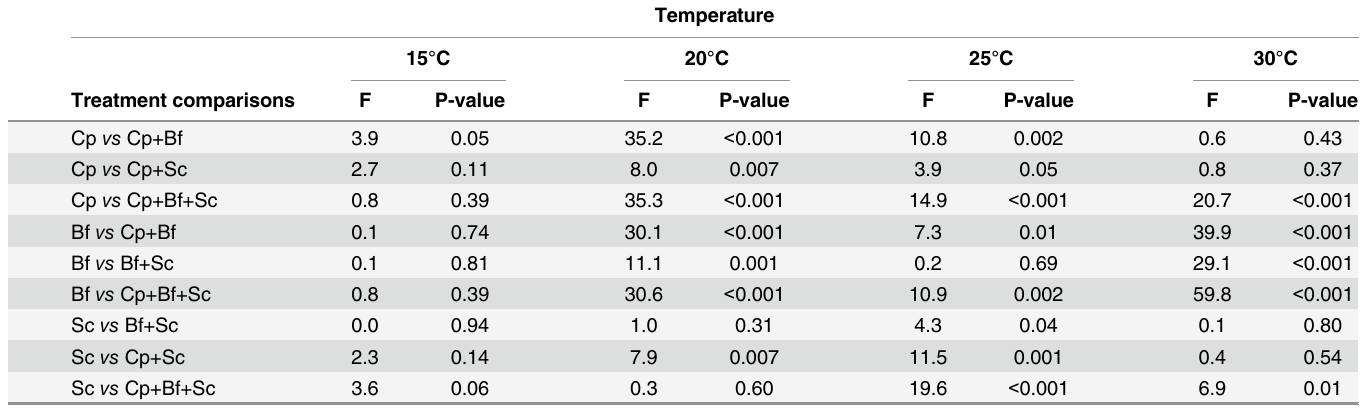
Table 6. Results of ANOVA comparing the relative growth rates between single-species and multi-species communities under different constant